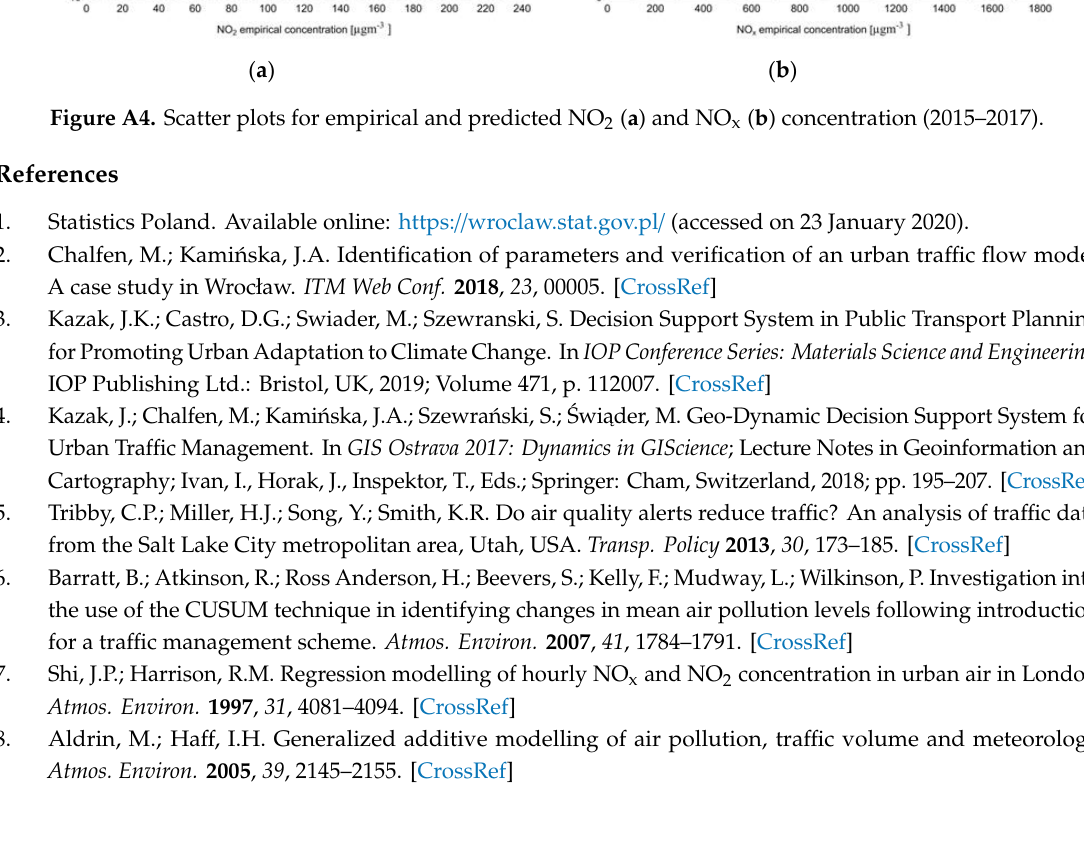
Figure A4. Scatter plots for empirical and predicted NO 2 ( a ) and NO x ( b ) concentration (2015–2017).